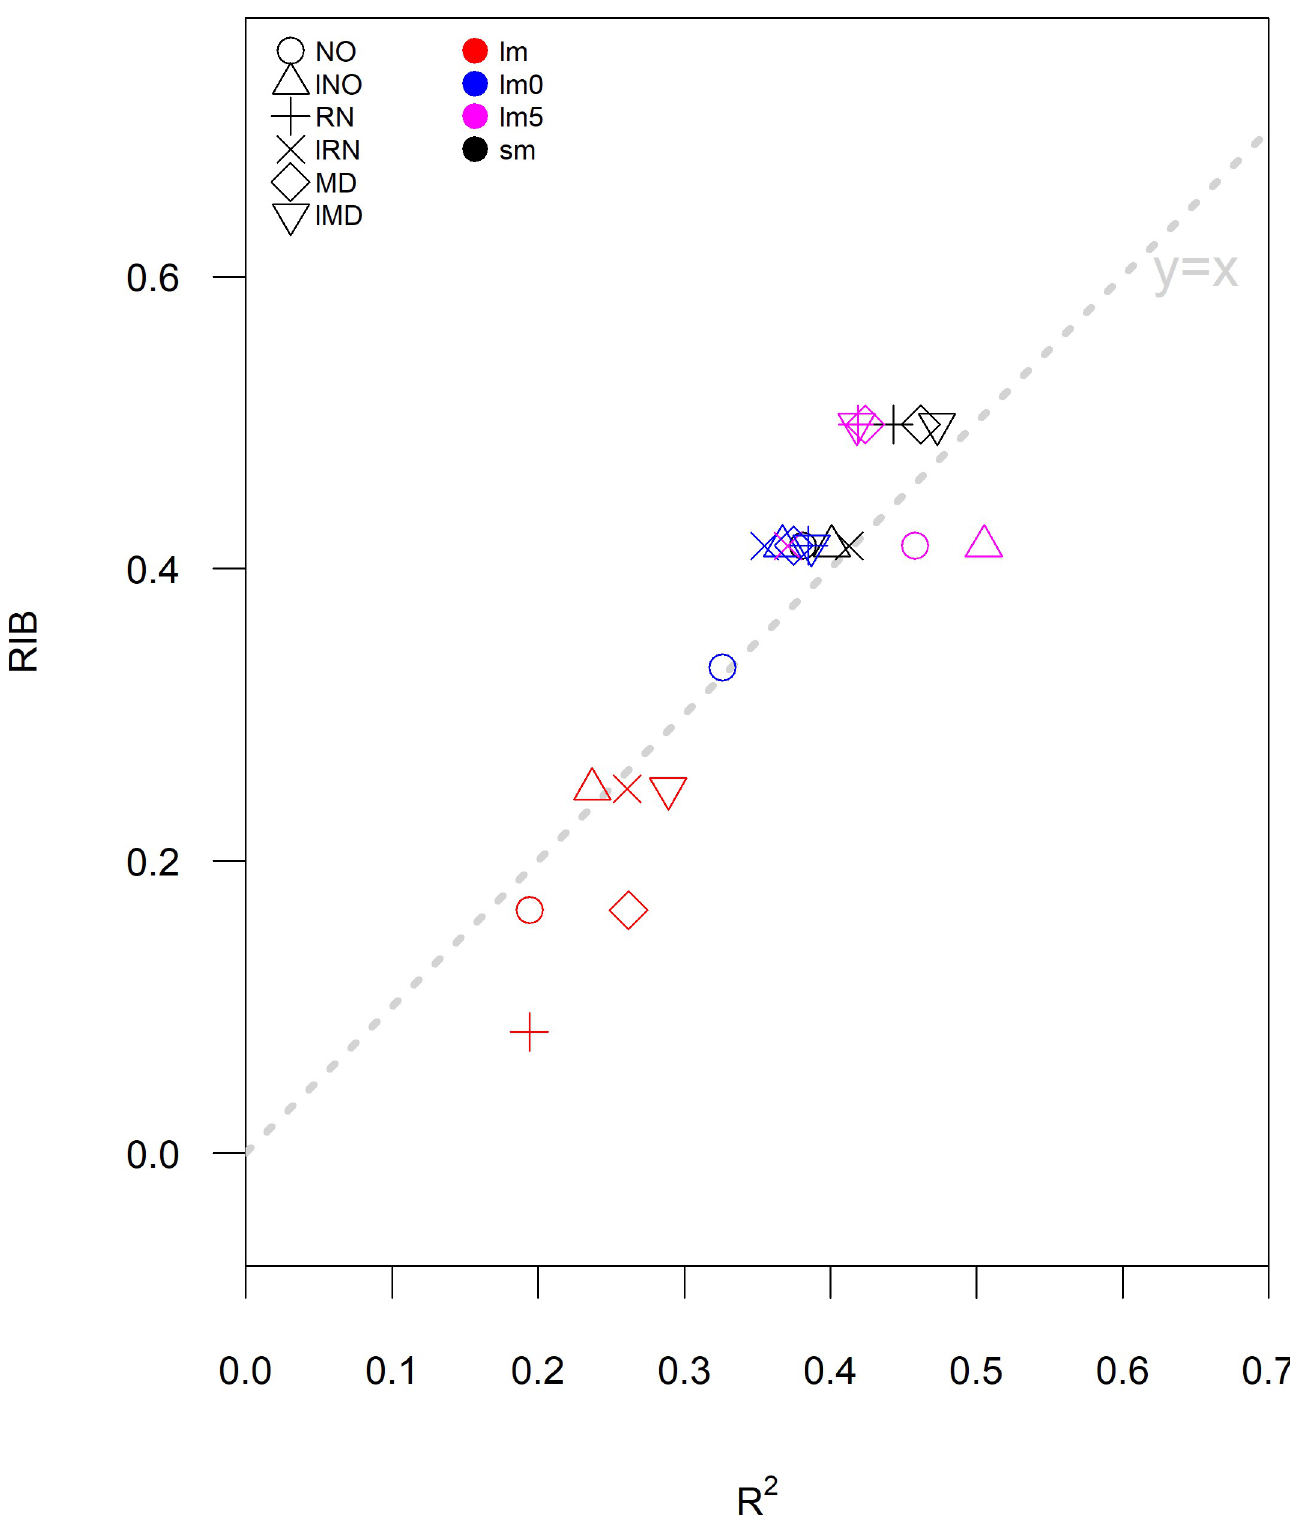
Fig 5. Relationship between R 2 and the relative insurance benefit ( RIB ) for the 24 combination of four regression modelling approaches: Linear (lm), piecewise linear with z-scores less than 0 (lm0), piecewise linear with z-scores less than -0.5 (lm5), and segmented regression (sm), using z-scores derived from six data sources: Log MODIS NDVI (LMD), log NOAA NDVI (LNO), log rainfall (LRN), MODIS NDVI (MD), NOAA NDVI (NO), and rainfall (RN).